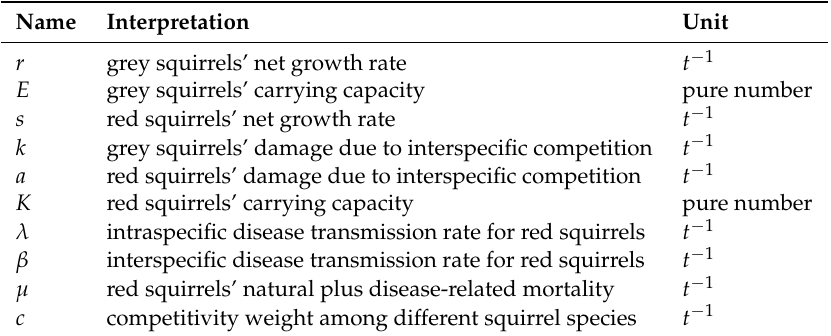
Table 1. A summary of the model parameters and their